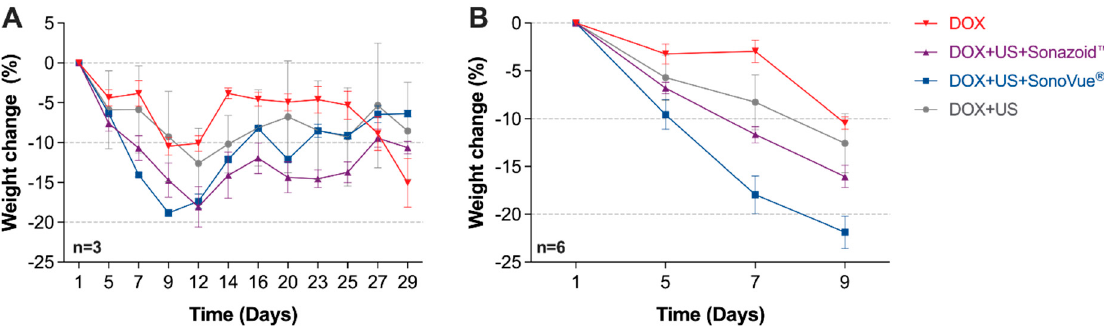
Figure 4. Percentage of weight change after a single treatment on day 1. During the first 2 weeks, there were signs of increased toxicity with increased weight loss in the groups receiving DOX + US + microbubbles ( A ) ( n = 3) for the whole study period and ( B ) ( n = 6) until day 9. DOX = Doxorubicin; US = Ultrasound.